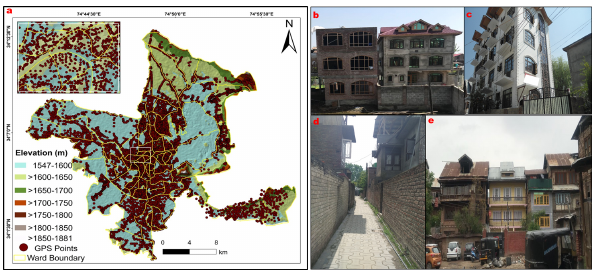
Figure 2. (a) Field validation map showing the distribution of ground samples, with the inset showing the density of samples. The elevation of the study area is based on the ASTER DEM data. Field photographs: (b) a modern masonry construction practice adopted in a residential area, (c) a commercial building with large window- panes, (d) the narrower roads in the city centre, and (e) the buildings with insufficient or no separation